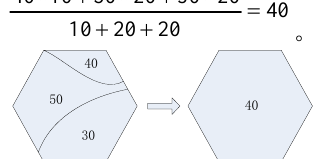
Figure 7. The average information mapping diagram